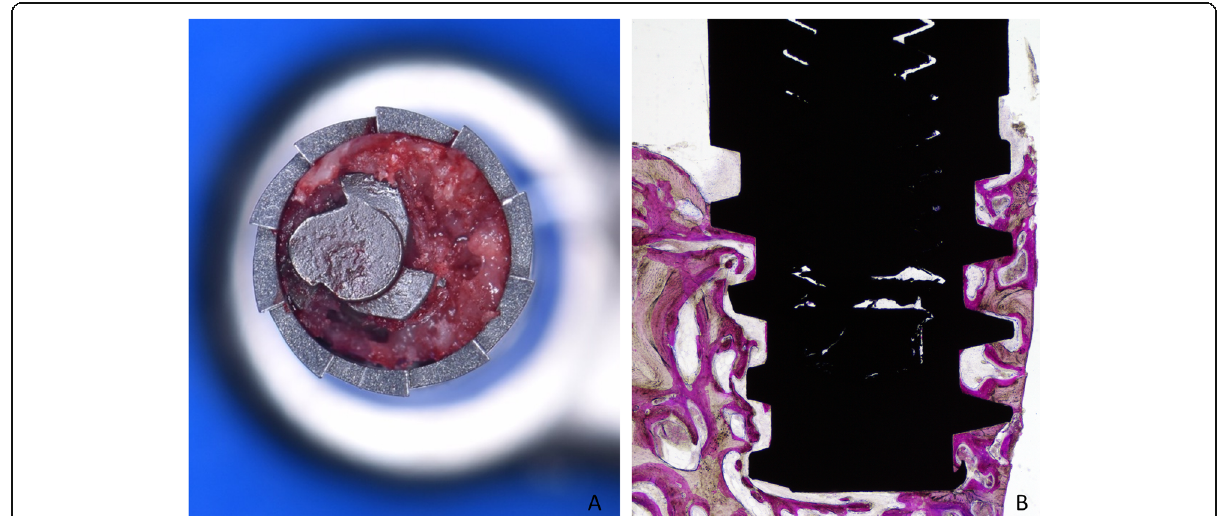
Fig. 3 a Trephine used in an eccentric way to reduce the size of the biopsies. b Ground section illustrating the shape of the